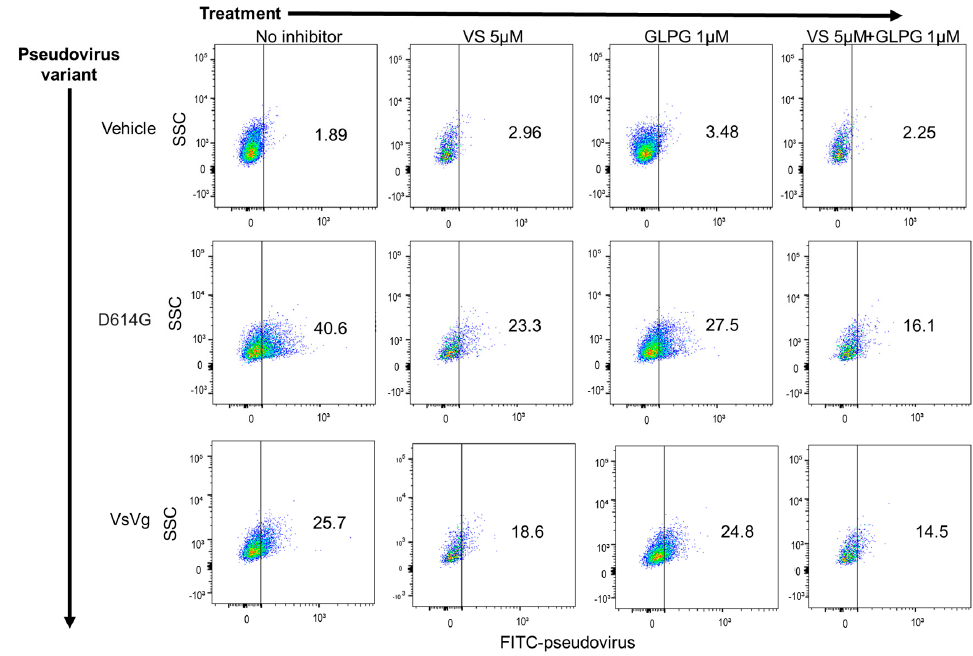
Figure 2. MEK inhibitor VS-6766 enhances the inhibition of SARS-CoV-2 pseudovirus infection by integrin inhibitor GLPG-0187 in small airway epithelial cells. Treatment with 5 µ M VS-6766 for 24 h or with 1 µ M GLPG-0187 for 3 h inhibits infection by the D614G pseudovirus variant (20 h infection time) in small airway epithelial cells compared to the VsVg positive control. DMSO was used as a vehicle control. Combination treatment involved 24 h pre-treatment with VS-6766 followed by an additional 3 h of treatment with GLPG-0187. The y axis shows side scatter, and the x axis shows FITC-pseudovirus